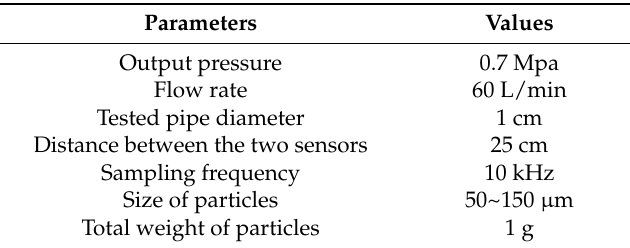
Table 1. Parameters of the experiment system.